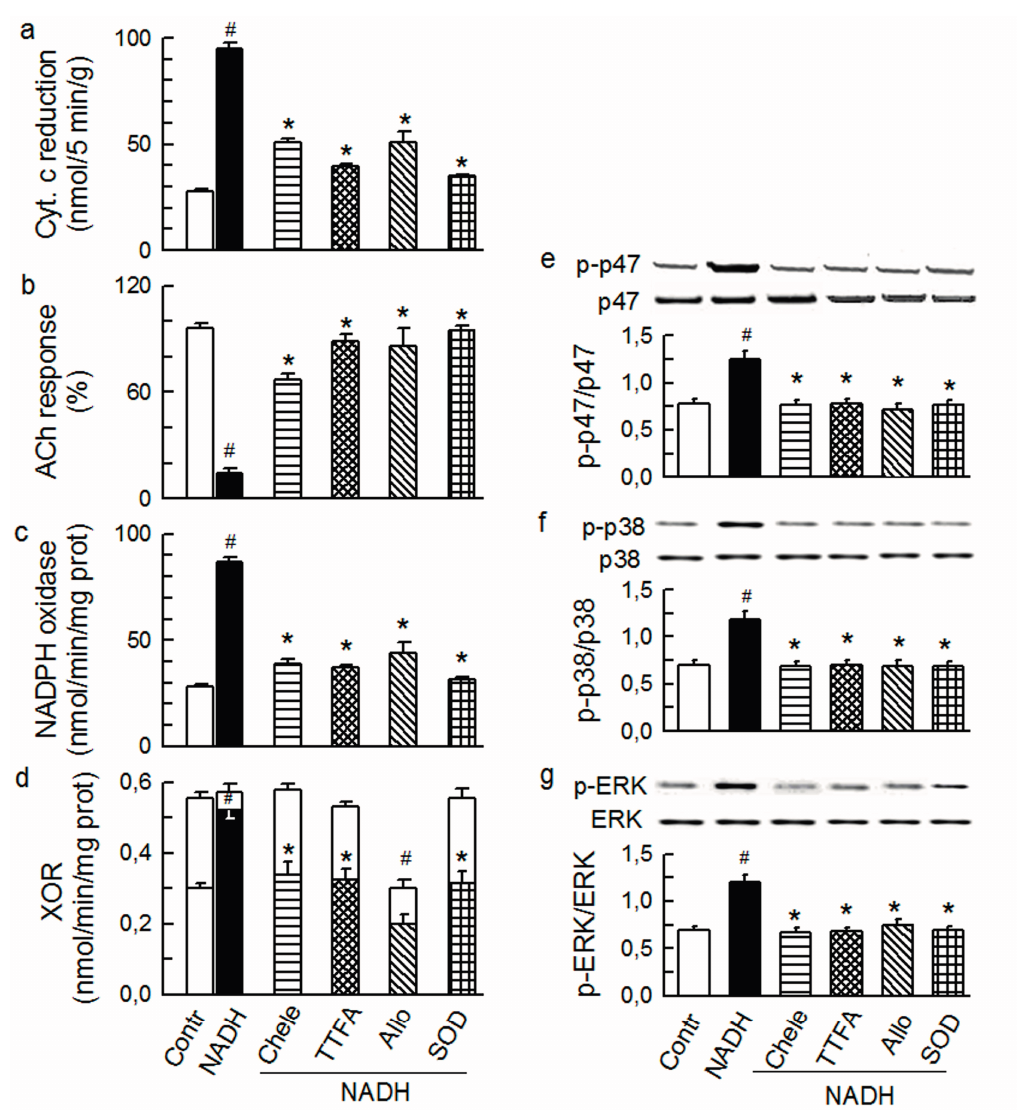
Figure 9. Effect of NADH (2.5 μ M) on the total outflow of reduced cytochrome c ( a ); normalised acetylcholine (ACh) response ( b ); NADPH oxidase activity ( c ); xanthine oxidoreductase activity (XOR) ( d ); the phosphorylation of Ser345-p47phox ( e ), p38 ( f ) and ERK1/2 ( g ) in guinea-pig hearts. NADH was administered either alone or in combination with (from left to right): 4 μ M chelerythrine (Chele), 5 μ M TTFA, 250 μ M allopurinol (Allo), and 150 IU/mL SOD. Values are means ± SEM of at least five experiments in a – d and of